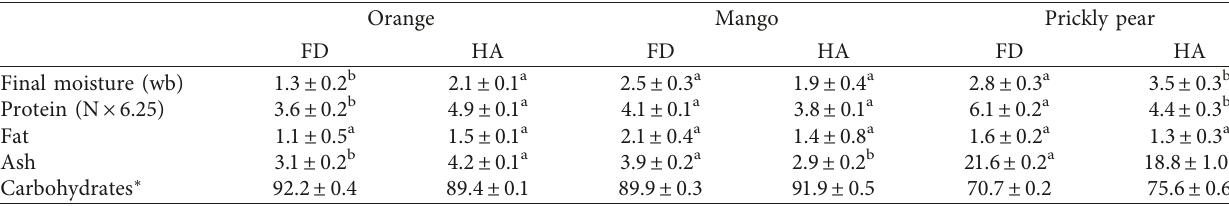
Table 2: Proximate composition (g · 100g − 1 db) of dietary fibre concentrates from orange, mango, and prickly pear peels freeze-dried (FD) and convective hot air-dried (HA).